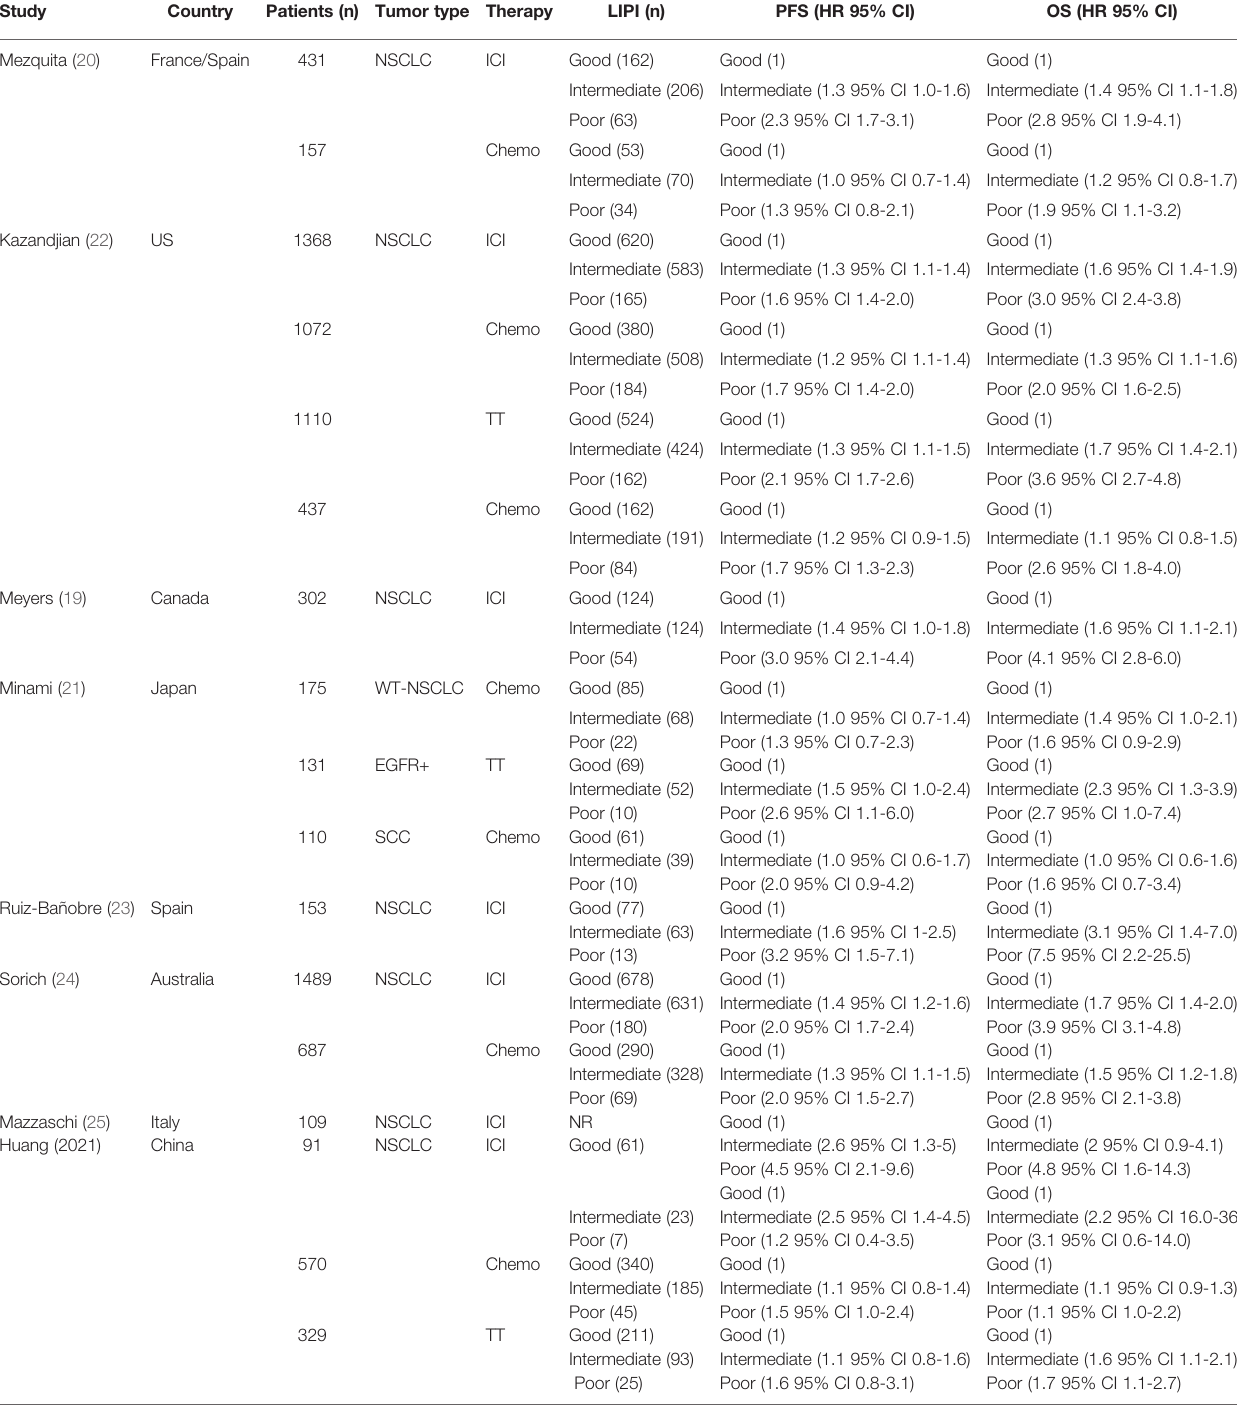
TABLE 2 | Baseline characteristics of included